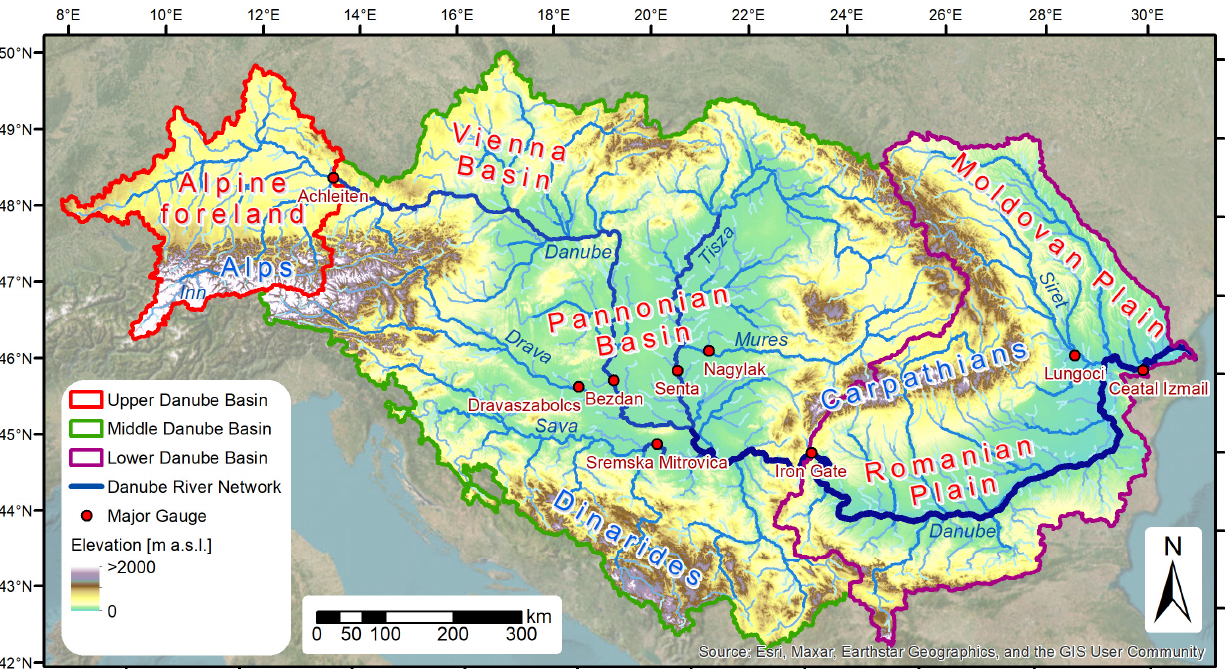
Figure 1. Map of the Danube River Basin with its river network, major gauges and the subdivision into Upper, Middle and Lower Danube. Major sub-basins (gauges in parentheses): Upper Danube (Achleiten), Middle Danube (Bezdan and Iron Gate), Drava (Dravaszabolcs), Sava (Sremska Mitrovica), Mures (Nagylak), Tisza (Senta), Siret (Lungoci) and the Lower Danube (Ceatal Izmail). Major gauges along the Danube main course: Achleiten, Bezdan, Iron Gate, Ceatal Izmail. Data sources: Farr et al. [27], Lehner et al. [28], Global Runoff Data Centre (GRDC) [29], International Commission for the Protection of the Danube River (ICPDR) [30] and Esri [31].